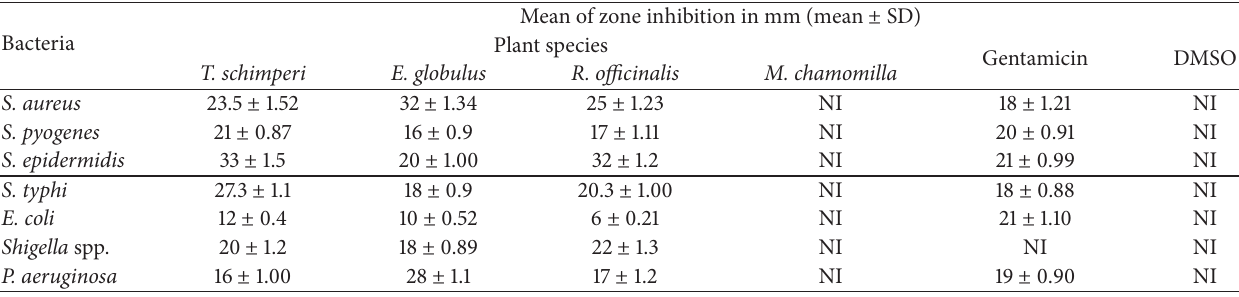
Table 2: Antimicrobial activity of the E. globulus , M. chamomilla , T. schimperi , and R. officinalis essential oil and standard antibiotics against bacteria.